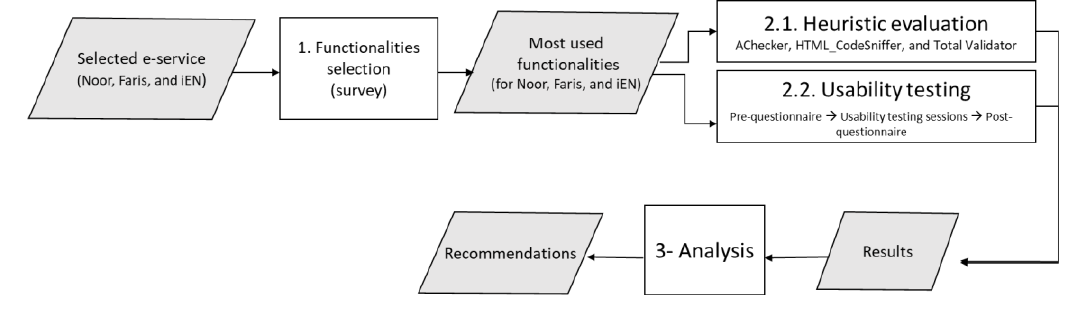
Figure 1. Methodology flowchart.